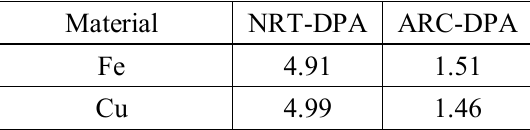
Table Ⅱ. Calculated values of